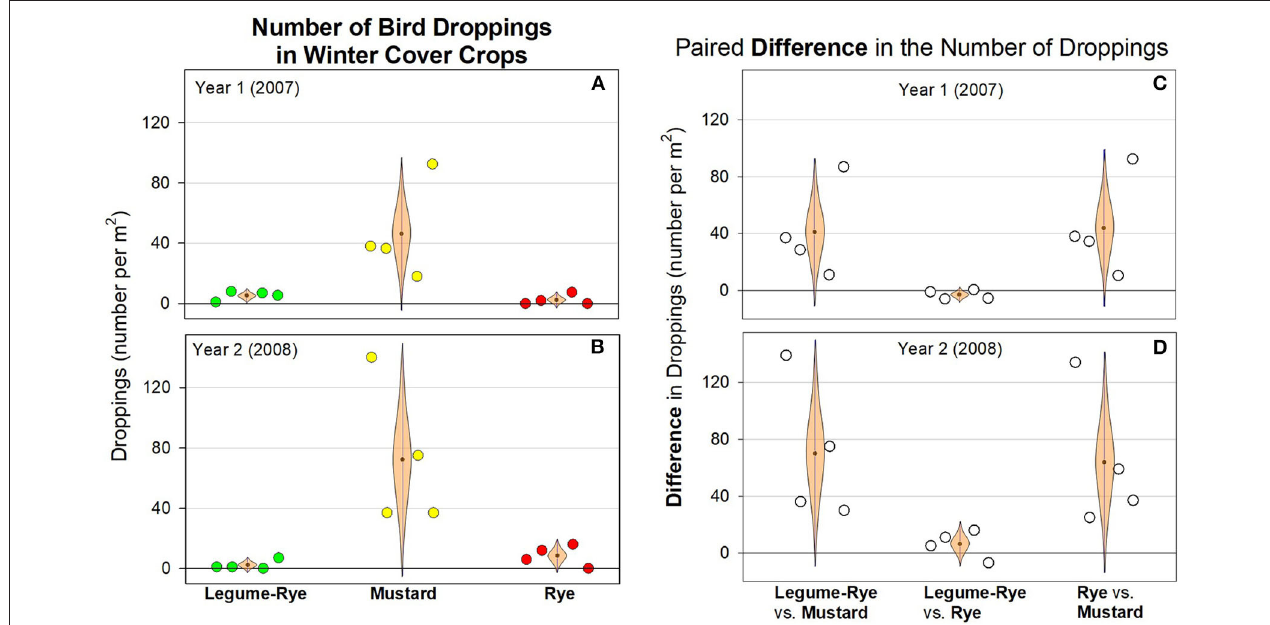
FIGURE 4 | The number (A,B) of bird droppings under three winter cover crops averaged, and their paired differences (C,D) , averaged across two seeding rates during two winters in Salinas, California. The data were collected in Feb 24 (Year 1) and Feb 13 to 15 (Year 2) that was ∼ 16–17 weeks after planting. The light brown, cat’s eye shaped error bars are 95% confidence intervals (CIs) with the sample mean at the central point on the bar. The CIs are shown in this shape to help illustrate how plausibility varies along the CI with the fattest (i.e., widest horizontal) areas near the mean being several times more plausible to be the population mean ( µ ) than the ends of the CI. Data points are clustered around the mean in order of replicates 1–4. The mean number of droppings per m 2 and the 95% CI in [ ] are 5 [0, 10] and 2 [ − 3, 7] in legume-rye, 46 [ − 5, 97] and 72 [ − 5, 150] in mustard, 2 [ − 3, 8] and 9 [ − 3, 20] in rye for Year 1 and Year 2, respectively. The mean difference in the number of droppings per m 2 for paired comparisons were 41 [ − 11, 93] and 70 [ − 10, 150] for legume-rye vs. mustard, − 3 [ − 8, 2] and 6 [ − 10, 22] for legume-rye vs. rye, and 44 [ − 11, 99] and 64 [ − 14, 142] for rye vs. mustard, in Year 1 and Year 2, respectively. See Supplementary Figures 1, 2 for additional details on the